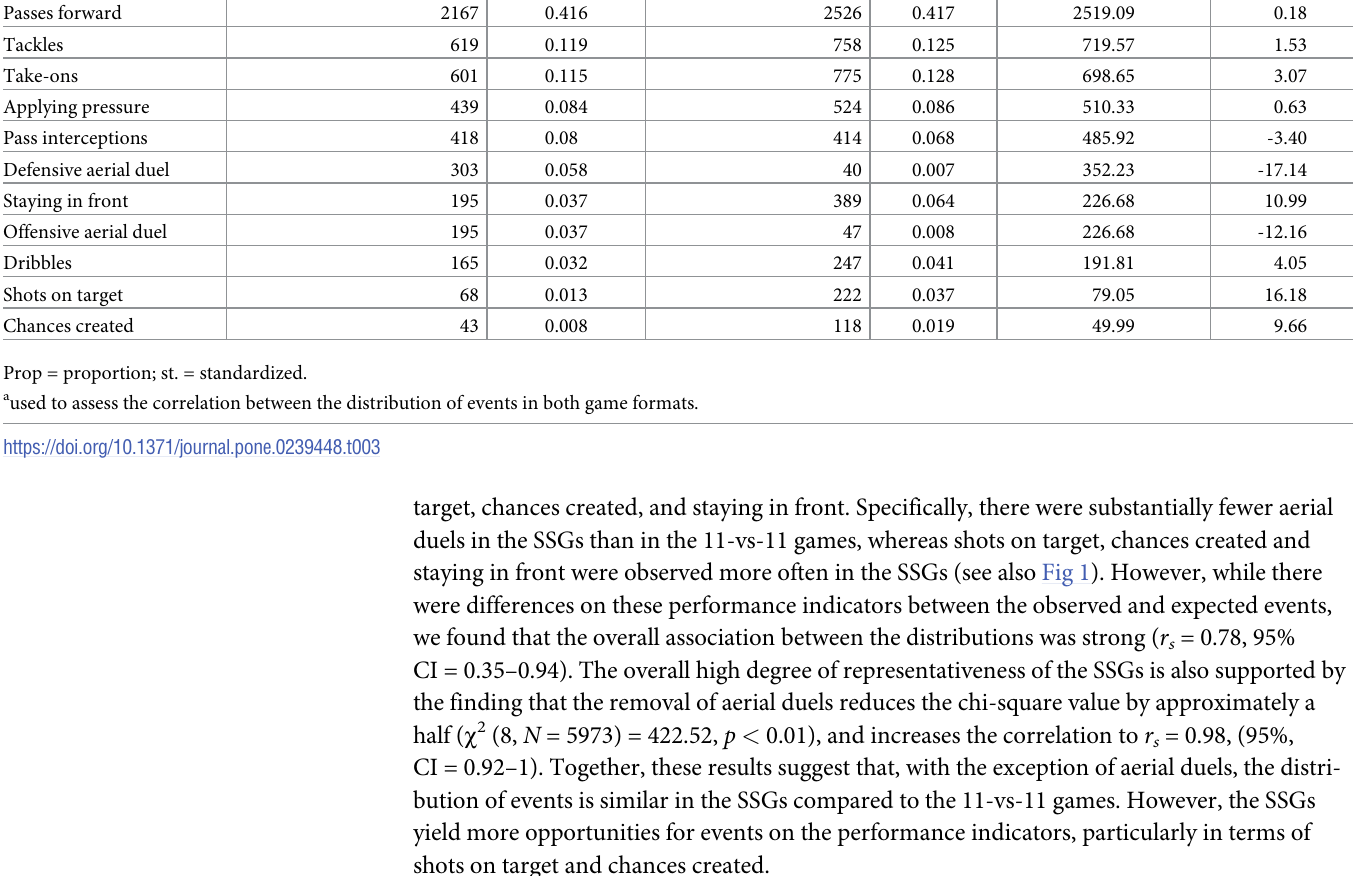
Table 3. Results from the chi-square goodness of fit test. χ 2 (10, N = 6060) = 923.79, p < 0.01